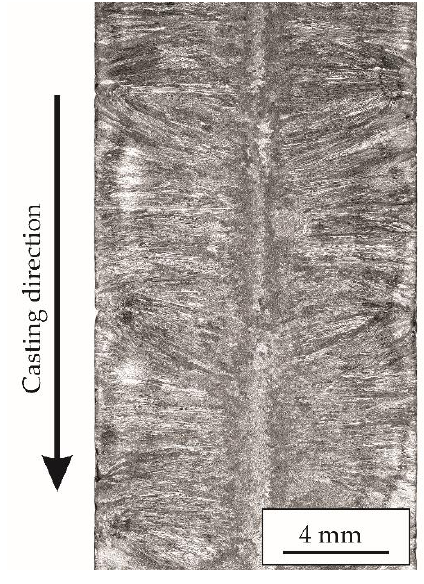
Figure 3. Longitudinal section of strand 2.